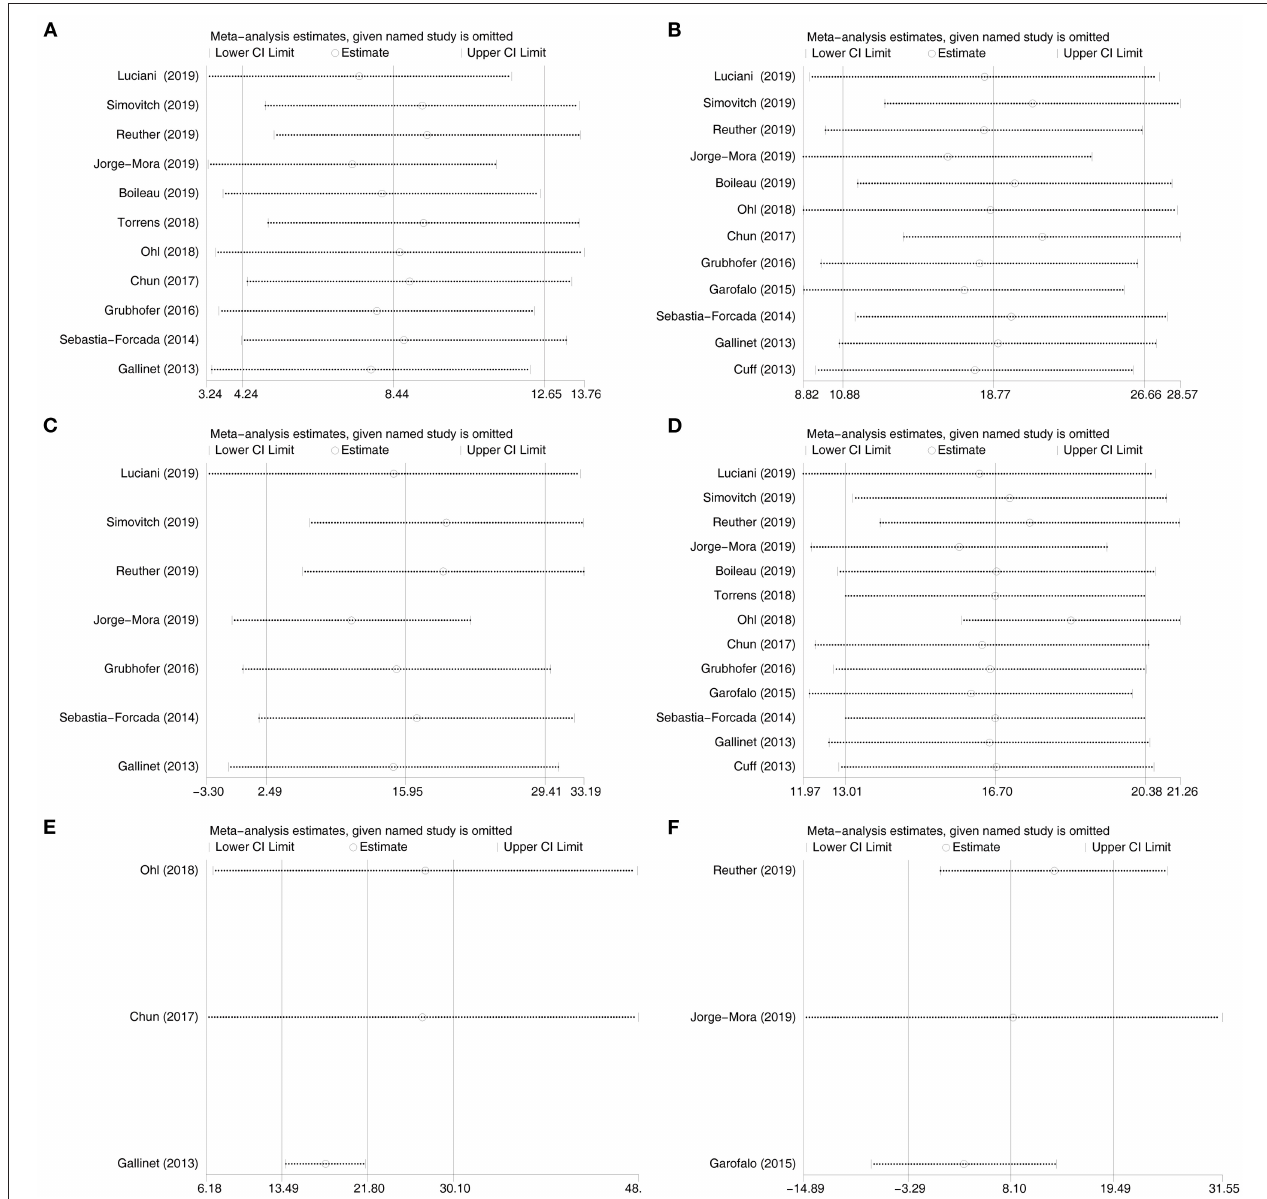
FIGURE 2 | Sensitivity analyses for the Constant score, flexion, abduction, external rotation, external rotation in 90 ◦ of abduction. and internal rotation between the healed groups and the non-healed groups. (A) : the Constant score, (B) : flexion, (C) : abduction, (D) : external rotation, (E) : external rotation in 90 ◦ of abduction, and (F) : internal